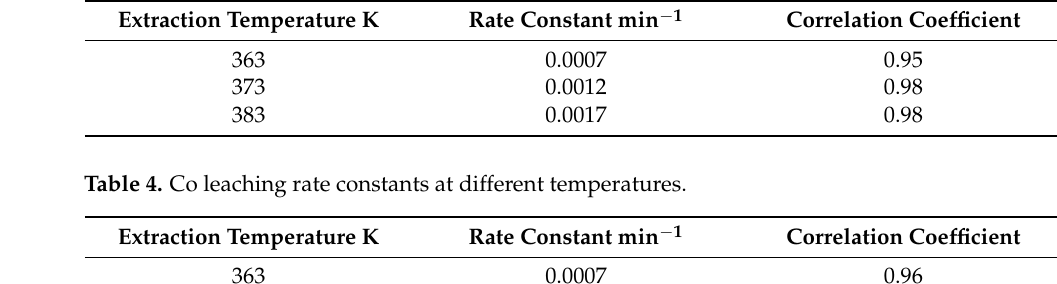
Table 3. Ni leaching rate constants at different temperatures.